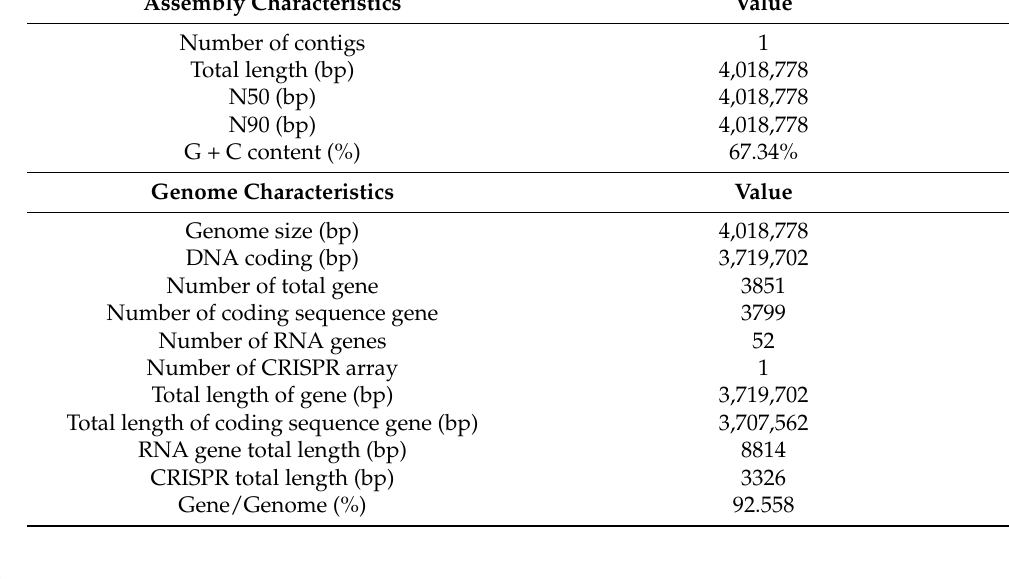
Table 1. Characteristics of E. keratini EPI-7 T genome. Table 2. Comparison of annotations between newly-generated and previous E. keratini EPI-7 T .